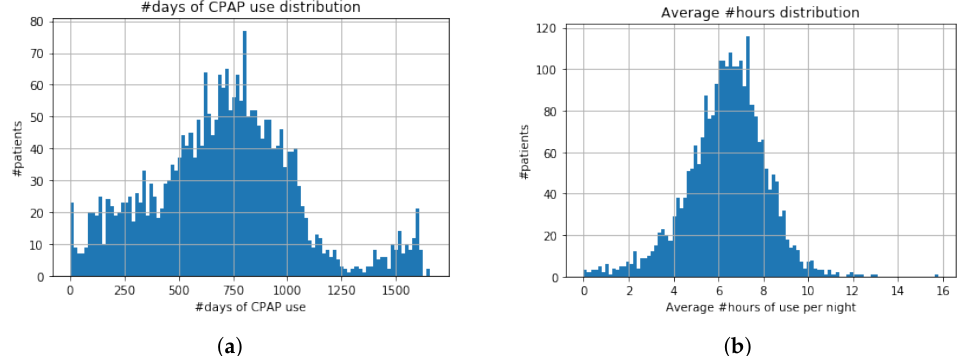
Figure 2. Basic distributions related to the CPAP use dataset. ( a ) Distribution of the length of the time series (number of days of use) found in the CPAP use dataset. We discarded patients with less than 181 days (6 months) of monitoring. ( b ) Distribution of the average number of hours of CPAP use considering all the patients with, at least, 181 days of monitoring.